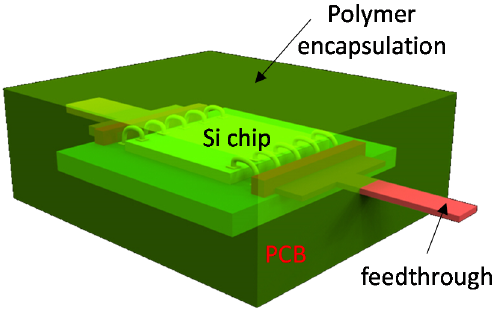
Figure 2. Polymer encapsulation of conventional package for biocompatible package. Table 1. Summarizes material properties and process conditions of polymer materials.